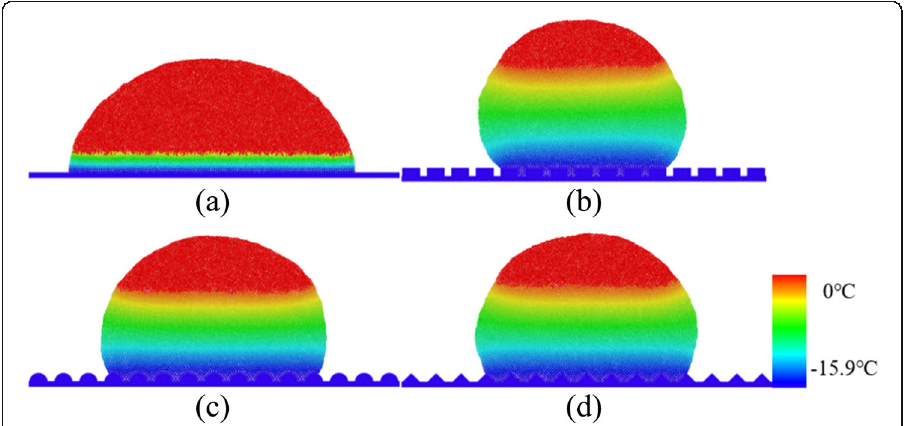
Fig. 7 Freezing of droplets on surfaces of different microstructures. ( a ) plane ( b ) square ( c ) semicircle ( d ) triangle